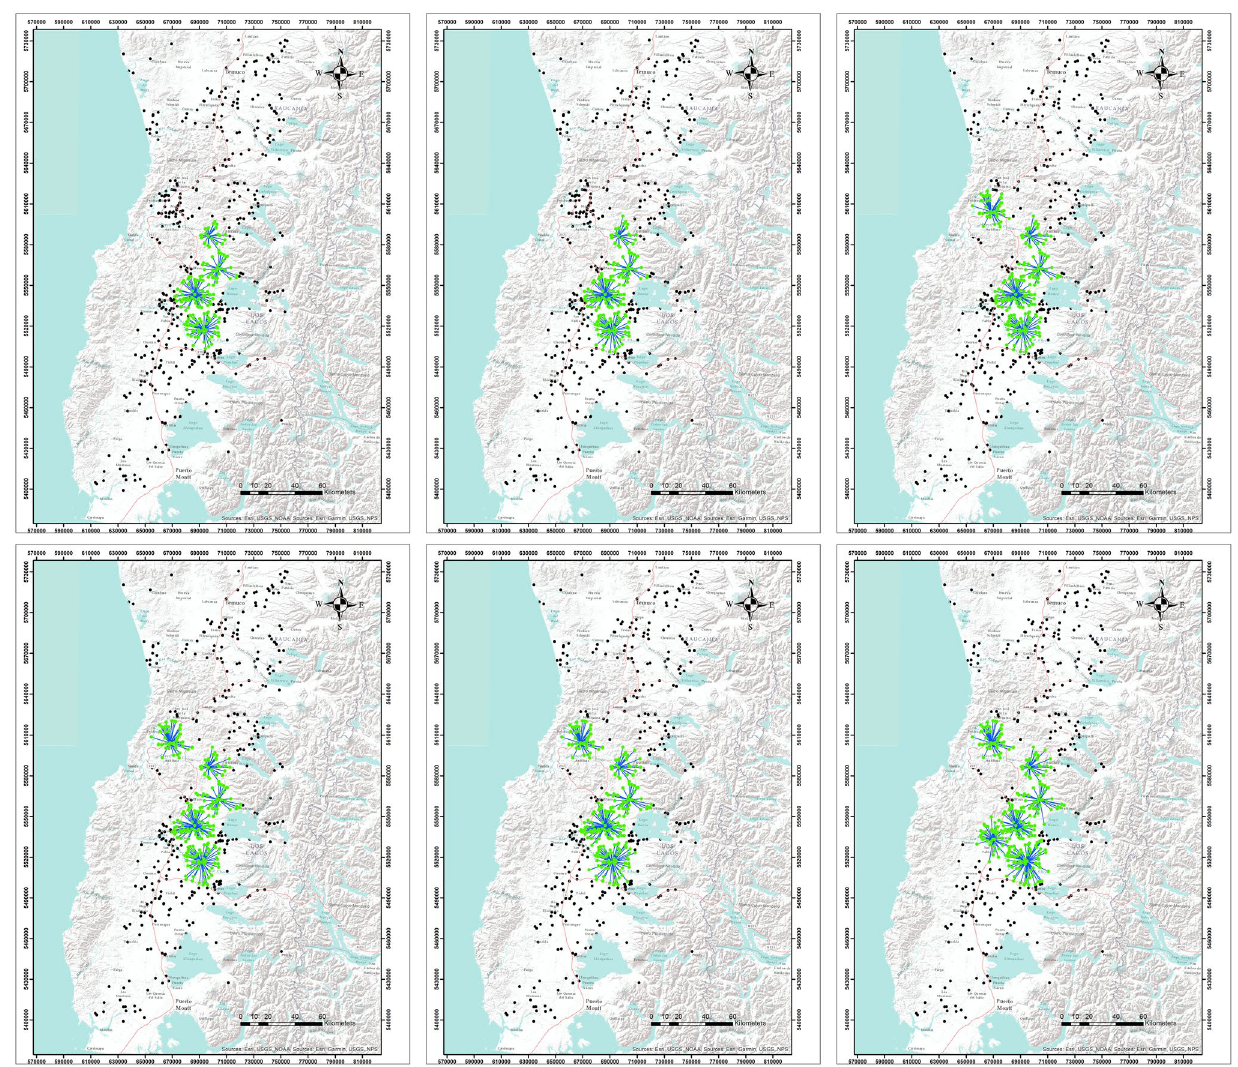
Fig. 9 Location of the configurations of the best combination found, with 70% biomass availability scenario, transport cost of 0.3 USD/tkm, and energy price of 90, 92, 94, 96, 98 and 100 USD/MWh, in order of